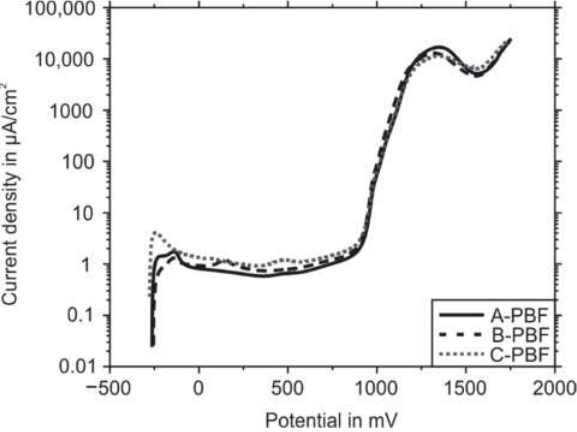
Figure 11. Current density/potential curves of the PBF-LB/M-processed samples. Table 6. Results of current/potential tests performed on the three PBF-LB/M-processed 316L variants in the as-built con- dition.